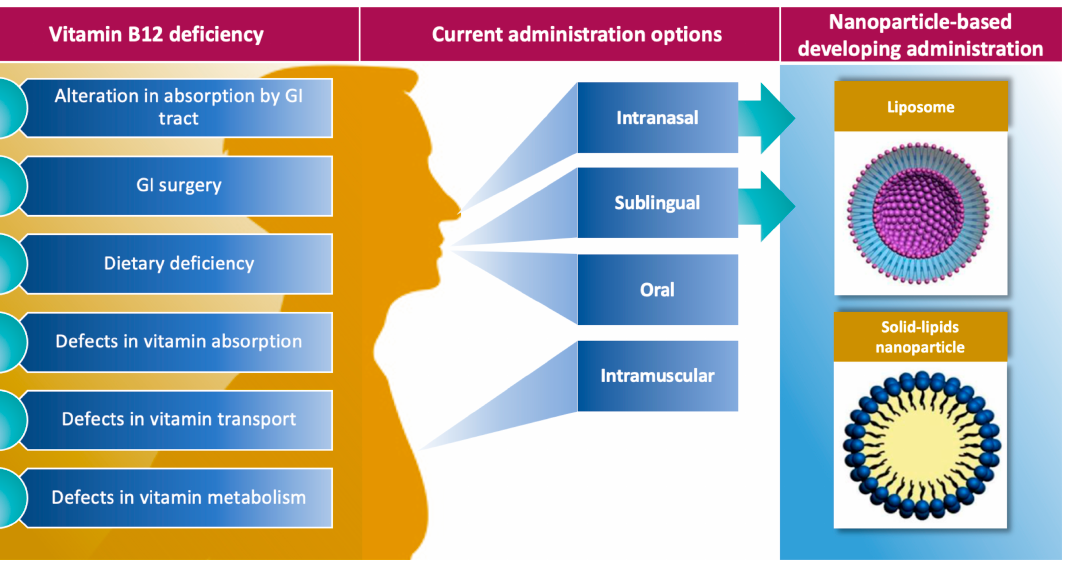
Figure 3. Current application of nanocarriers in VitB12 administration. The scheme summarizes the causes of VitB12 deficiency, the current administration options, and the nanoparticle-based developing administration.